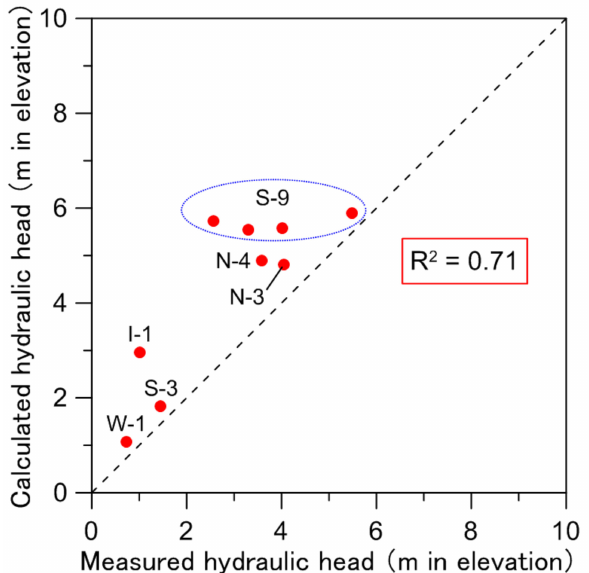
Figure 4. Comparison of measured hydraulic heads with calculated